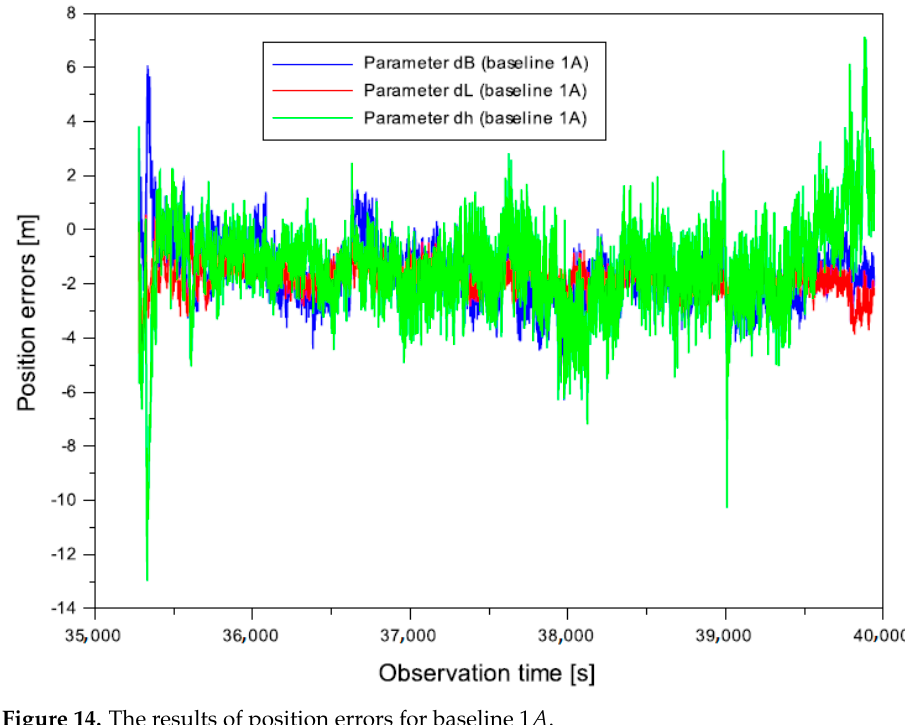
Figure 14. The results of position errors for baseline 1 A .